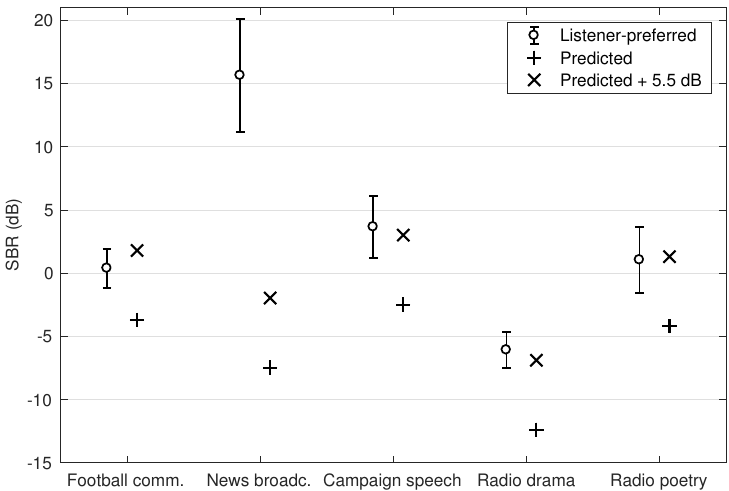
Figure 6. Listener-preferred (circle) SBR and predicted SBR min (grey cross) for the audio scenes listed in Table 2. Values represented by ‘x’ markers are resulted from applying a constant 5.5 dB gain to the predicted SBR min for each scene. Error bar indicates 95% confidence interval of the